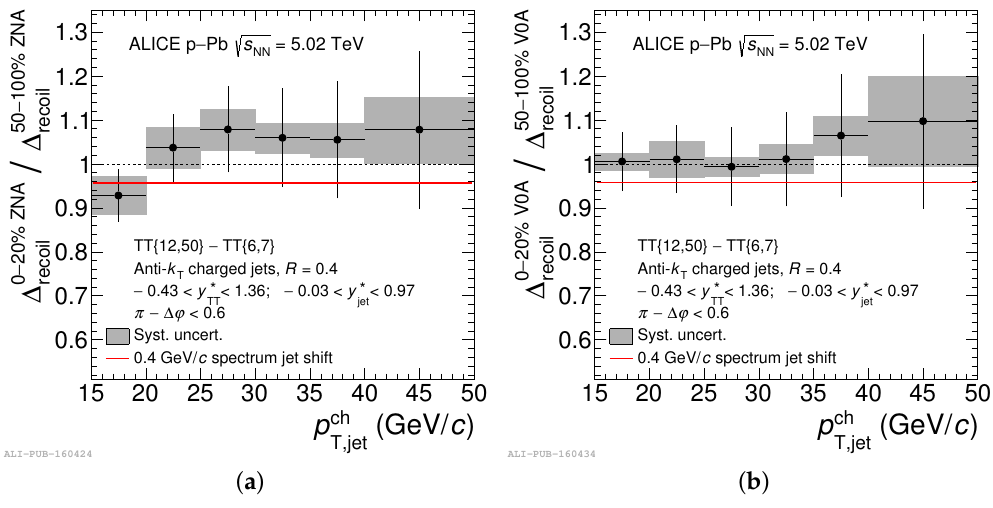
√ s NN = 5.02TeV in